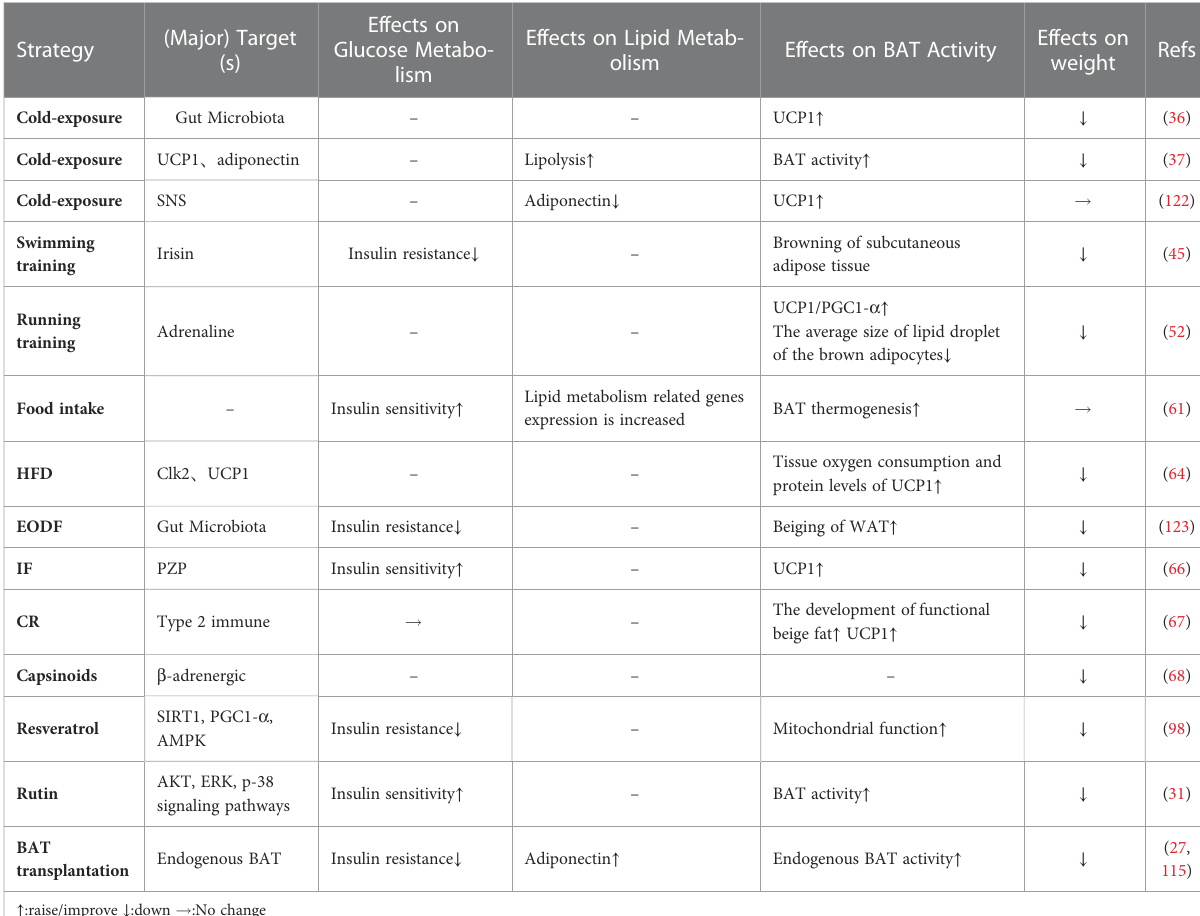
TABLE 4 Different ways to improve the BAT activity or browning of